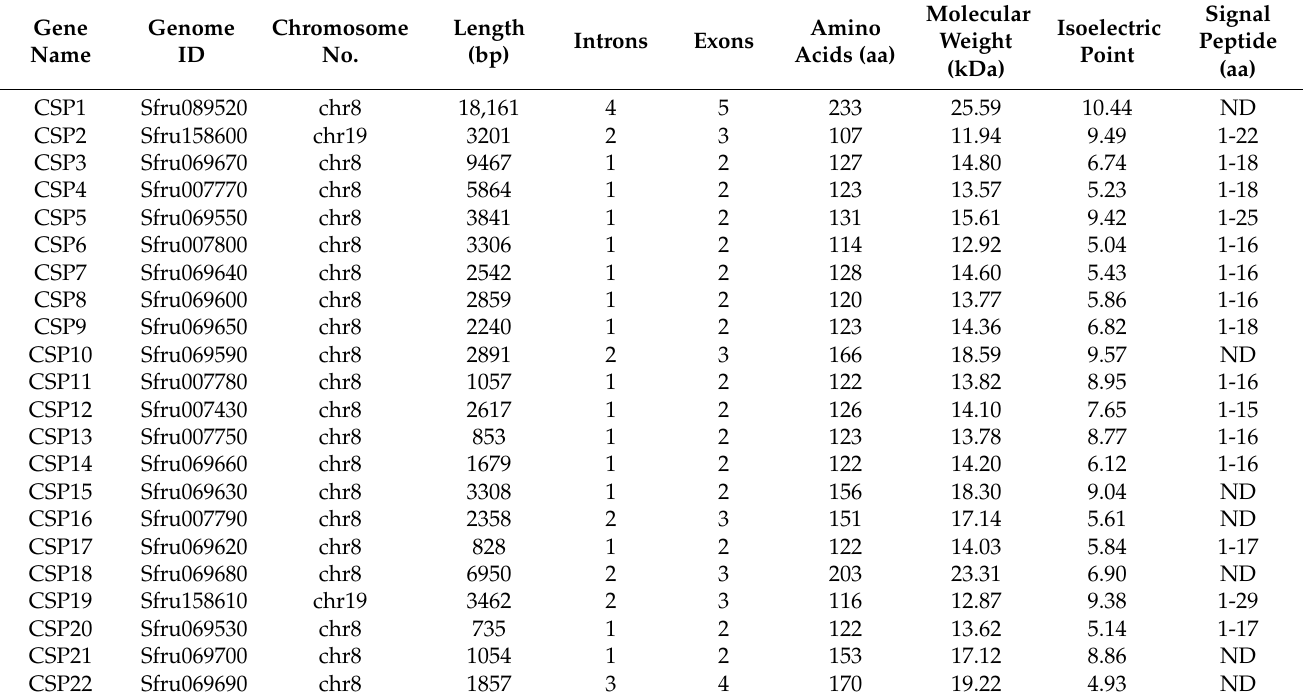
Table 2. Physical and molecular properties of 22 SfruCSPs identified in the Fall armyworm ( S. frugiperda ). ND: not